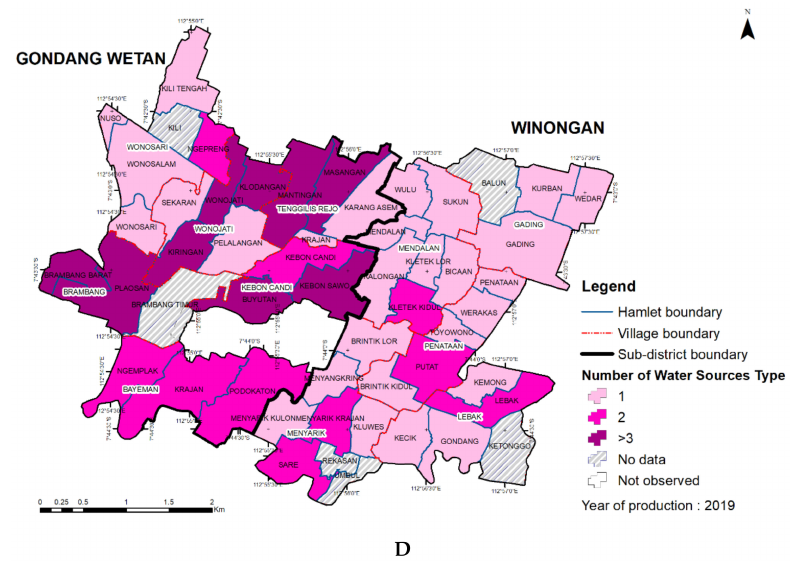
Figure 8. Spatial distribution of the number of artesian wells ( A ), drainage density ( B ), the hamlets that use the river as the main water resource ( C ), and the number of water resources ( D ) at hamlet